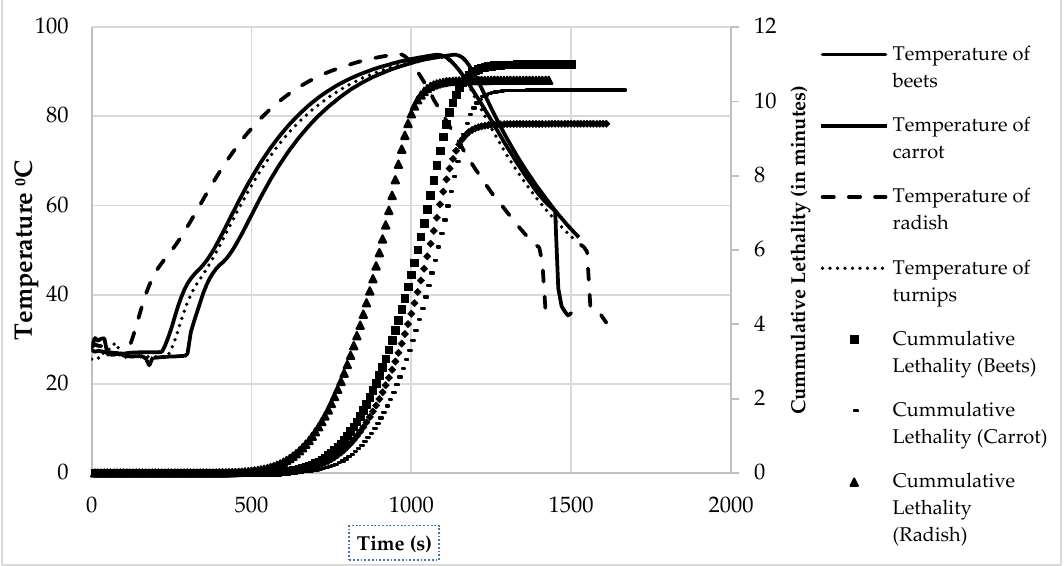
Figure 2. Temperature and lethality values obtained for processed acidified vegetable pieces during the cooking at 100 °C [Po (90 °C) values]. Table 1. Commercial sterilization and pasteurization times for